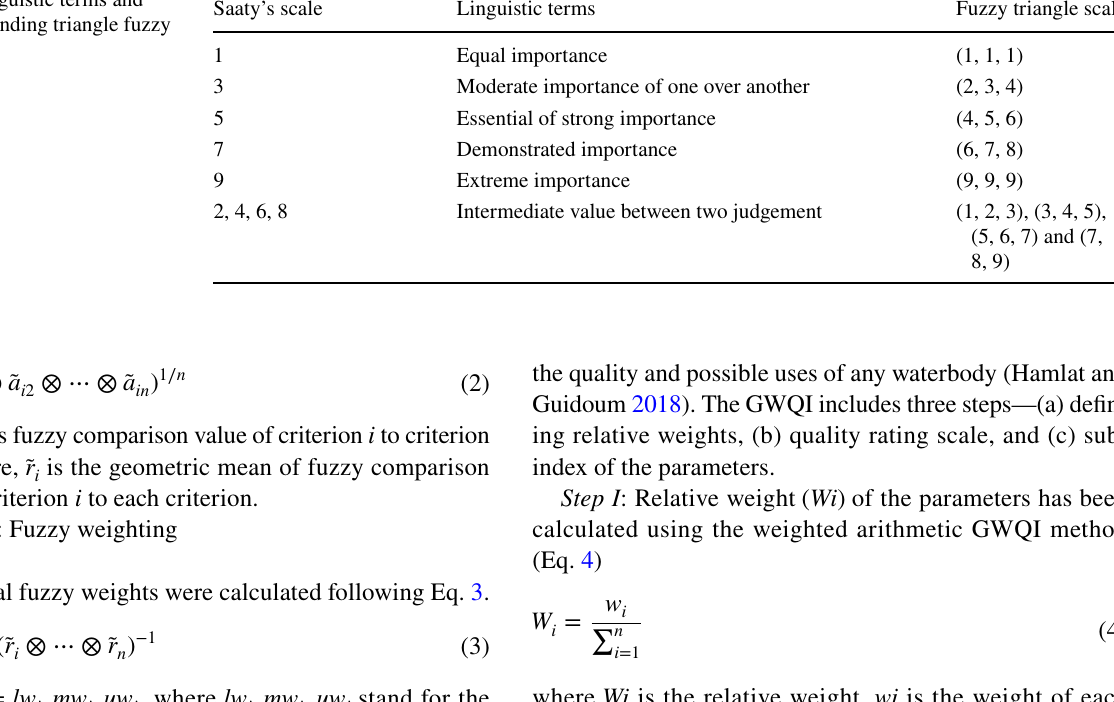
Table 1 Linguistic terms and the corresponding triangle fuzzy